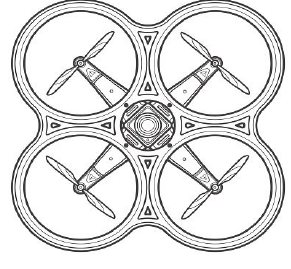
Fig. 1. An example of a quadcopter device